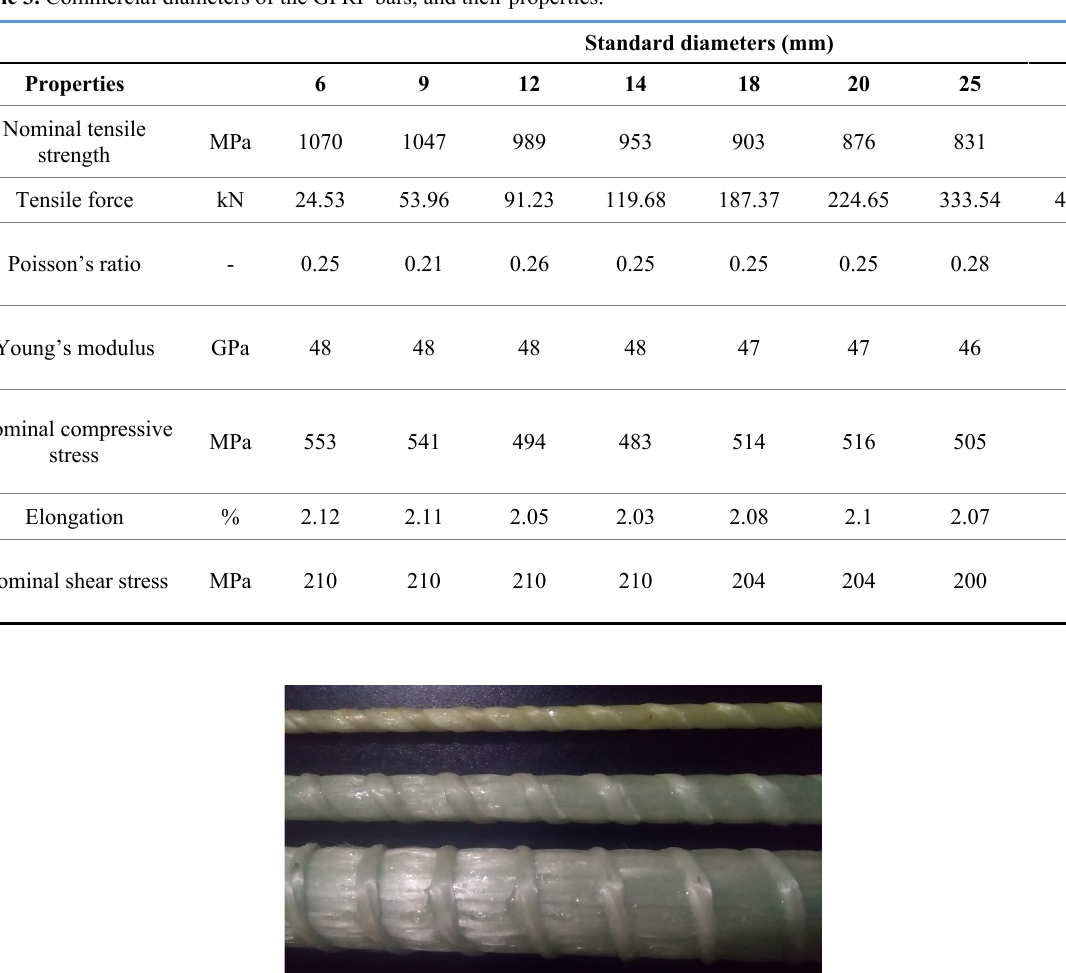
Table 3. Commercial diameters of the GFRP bars, and their properties.